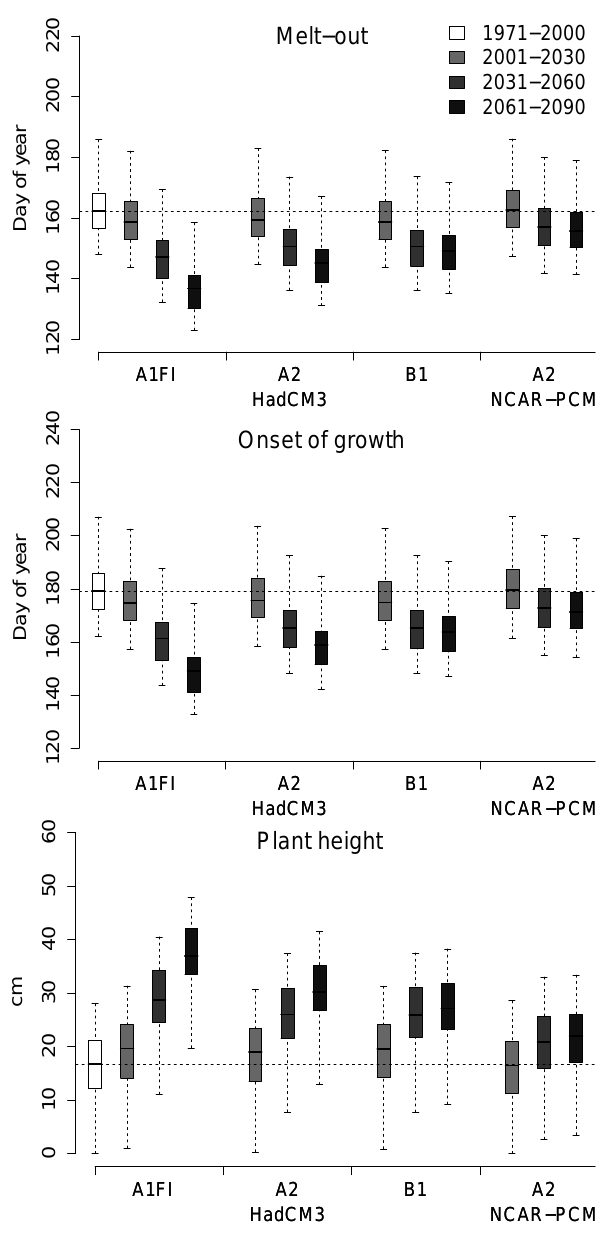
Fig. 4. Melt out ( V M ), onset of growth ( V G ), and plant height ( V P ) as projected from mean May/June temperatures from low resolu- tion climate model ensemble ( T sim low ). The box plots show the range of data for the specified period. The black line within the box denotes the median, the box gives the upper and lower quartile, which contains 50% of the data and the whiskers give the minimum and maximum of the data. Note that only gridcells with an altitude > 1500m and within the observed temperature range were included in the